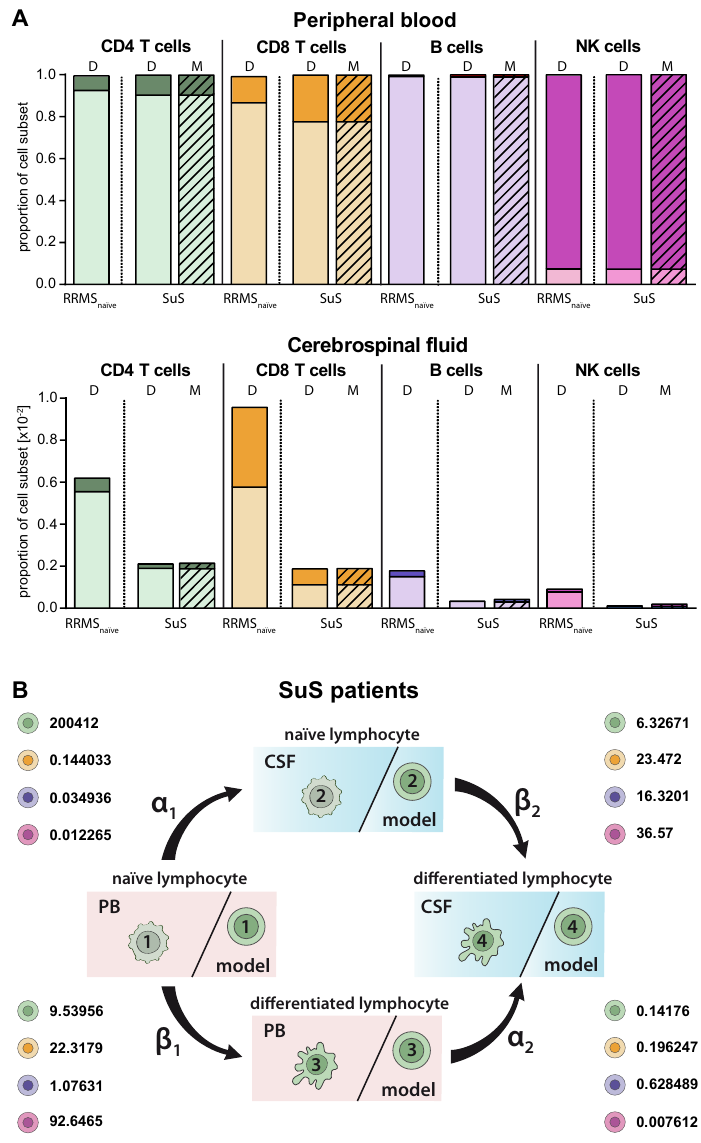
Figure 5. Adjustment of the model to describe alterations in lymphocyte subset transmigration and di ff erentiation in SuS patients. ( A ) Comparison of naïve (light colors) and di ff erentiated (dark colors) lymphocyte-subset derived data (D, Table S1) from SuS patients ( N = 14) and data calculated by the model (M, hatched bars) with data derived from therapy naïve RRMS patients ( N = 216) in the PB (top) and CSF (bottom). ( B ) Rates (%) determined by the model indicating the transitions from (i) naïve lymphocytes in the PB compartment to the CSF compartment ( α 1 ), (ii) naïve lymphocytes to di ff erentiated lymphocytes within the PB ( β 1 ), (iii) di ff erentiated lymphocytes from the PB to the CSF compartment ( α 2 ), and (iv) naïve lymphocytes to di ff erentiated lymphocytes within the CSF ( β 2 ) of SuS patients are displayed for the respective lymphocyte